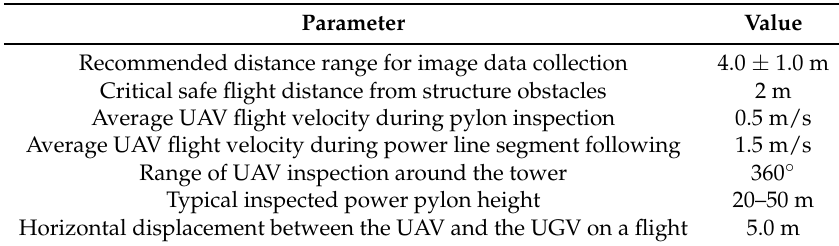
Figure 2. Architecture components. ( a ) Inspection site: base station, RTK-GPS, and UAV. ( b ) Detail of the Bebop drone with RTK-GPS module and Pioneer P3 with the augmented reality tag (AR-Tag). Table 2. Inspection parameters defined for the